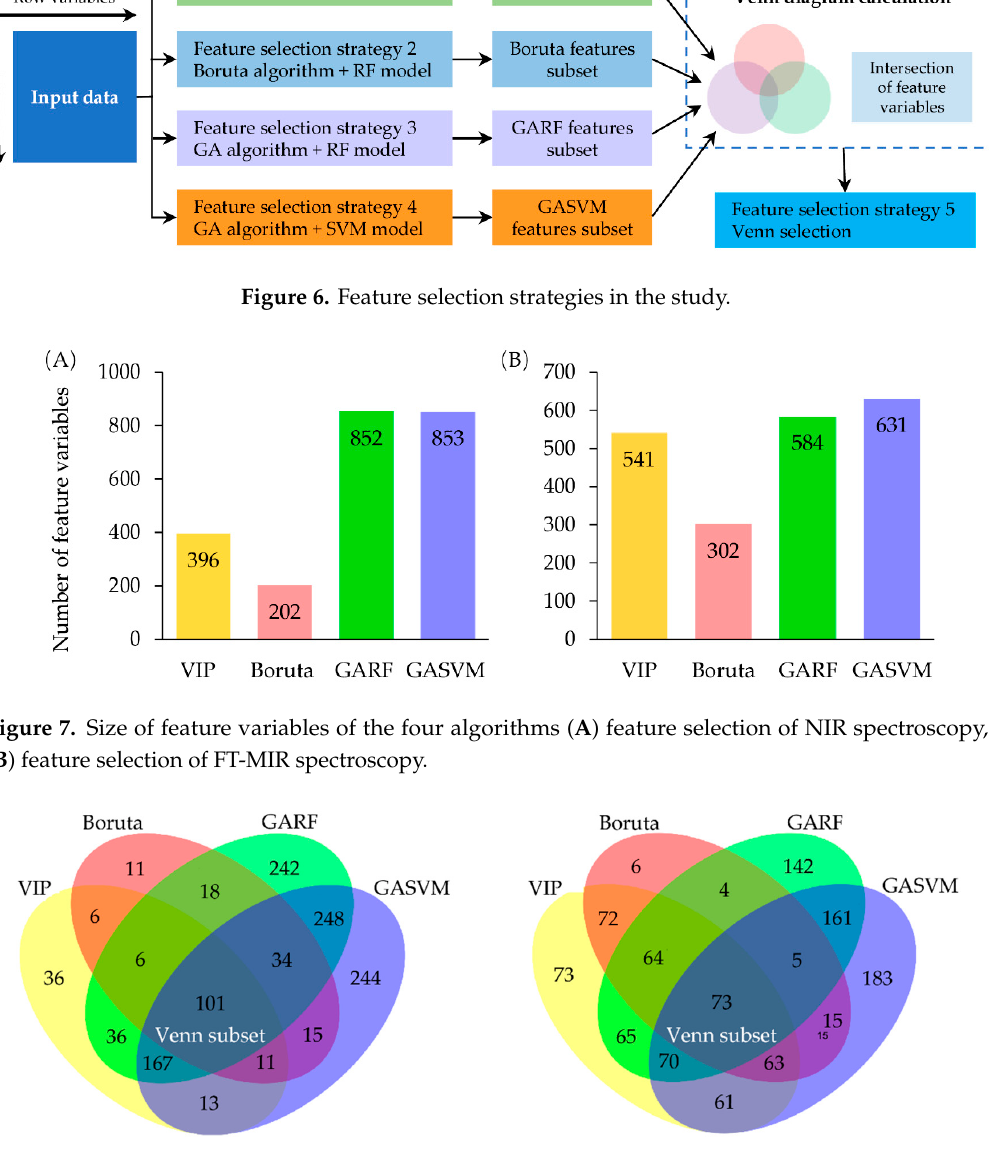
Figure 8. Venn diagram representing the overlap of the selected feature variables by variable importance in projection (VIP), Boruta, genetic algorithm combined with random forest (GARF), and genetic algorithm combined with support vector machine (GASVM) algorithms ( A ) Venn diagram